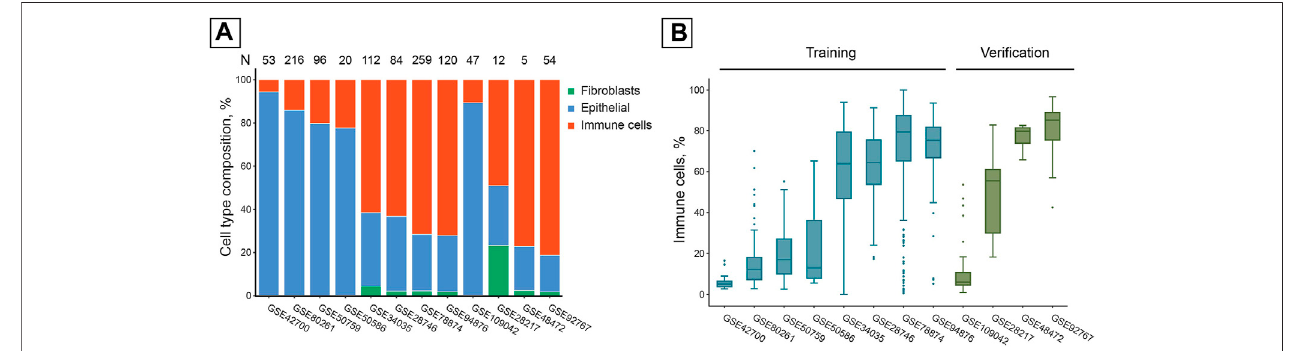
FIGURE 1 | Publicly available studies of DNAm in saliva samples have high inter- and intra-study cell composition variability. (A) Average cell composition of saliva samplesinthestudiesused,estimatedwithEpiDISHDNAmdeconvolution.N (cid:1) Totalnumberofsamplesinastudy. (B) Immunecelldistributionswithinthestudiesused. Boxes correspond to the IQR, whiskers protrude no further than 1.5 × IQR. Boxes are colored according to their inclusion in the training or veri fi cation set.